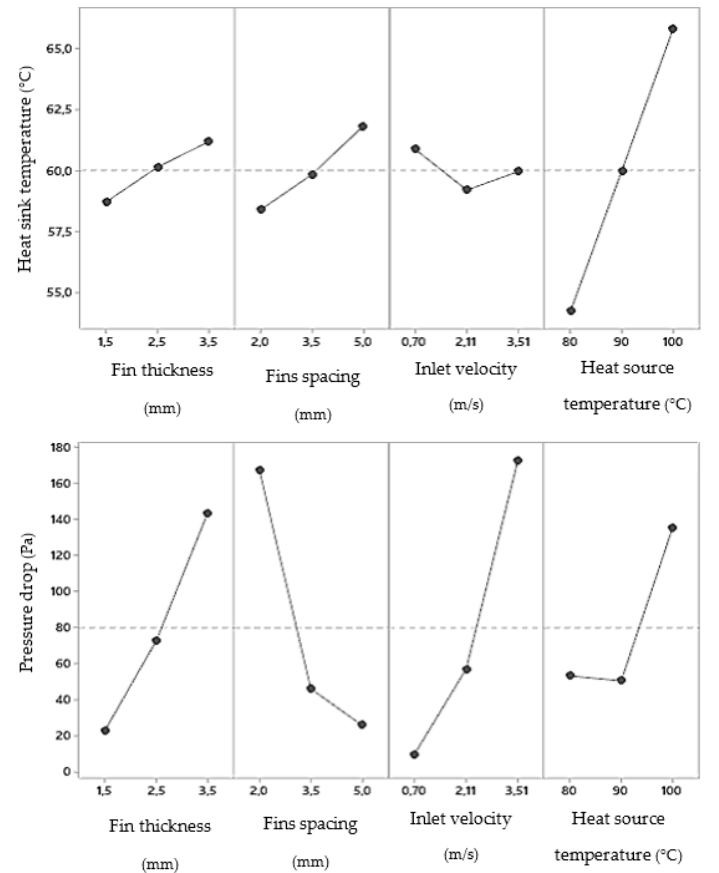
Figure 7. Main effects for heat sink temperature ( top ) and pressure drop ( bottom ) for fins heat sinks.